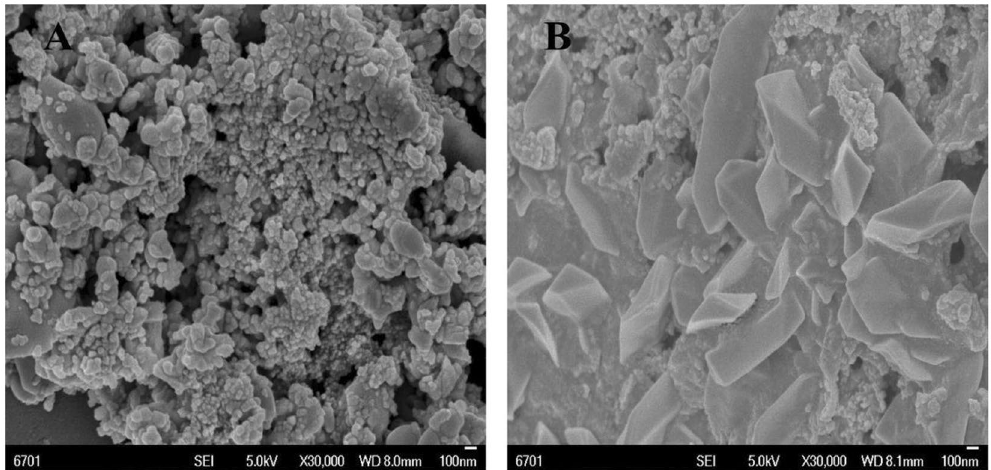
Figure 2. SEM patterns of pure A g-C 3 N 4 and B g-C 3 N 4 /Ni x Co 1 − x S 2 nanocomposite